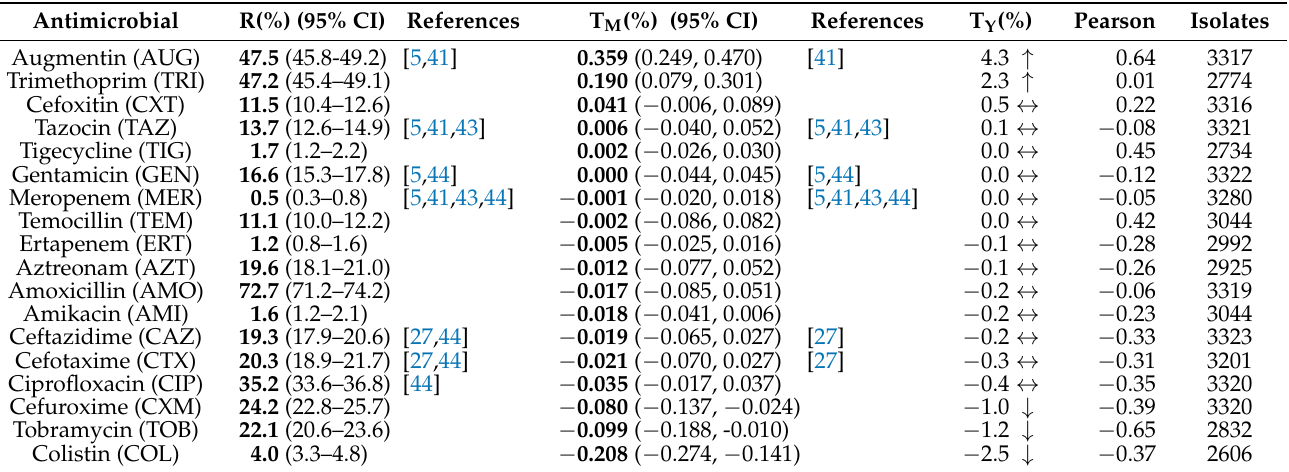
Table 3. AMR summary for E. coli in blood samples.